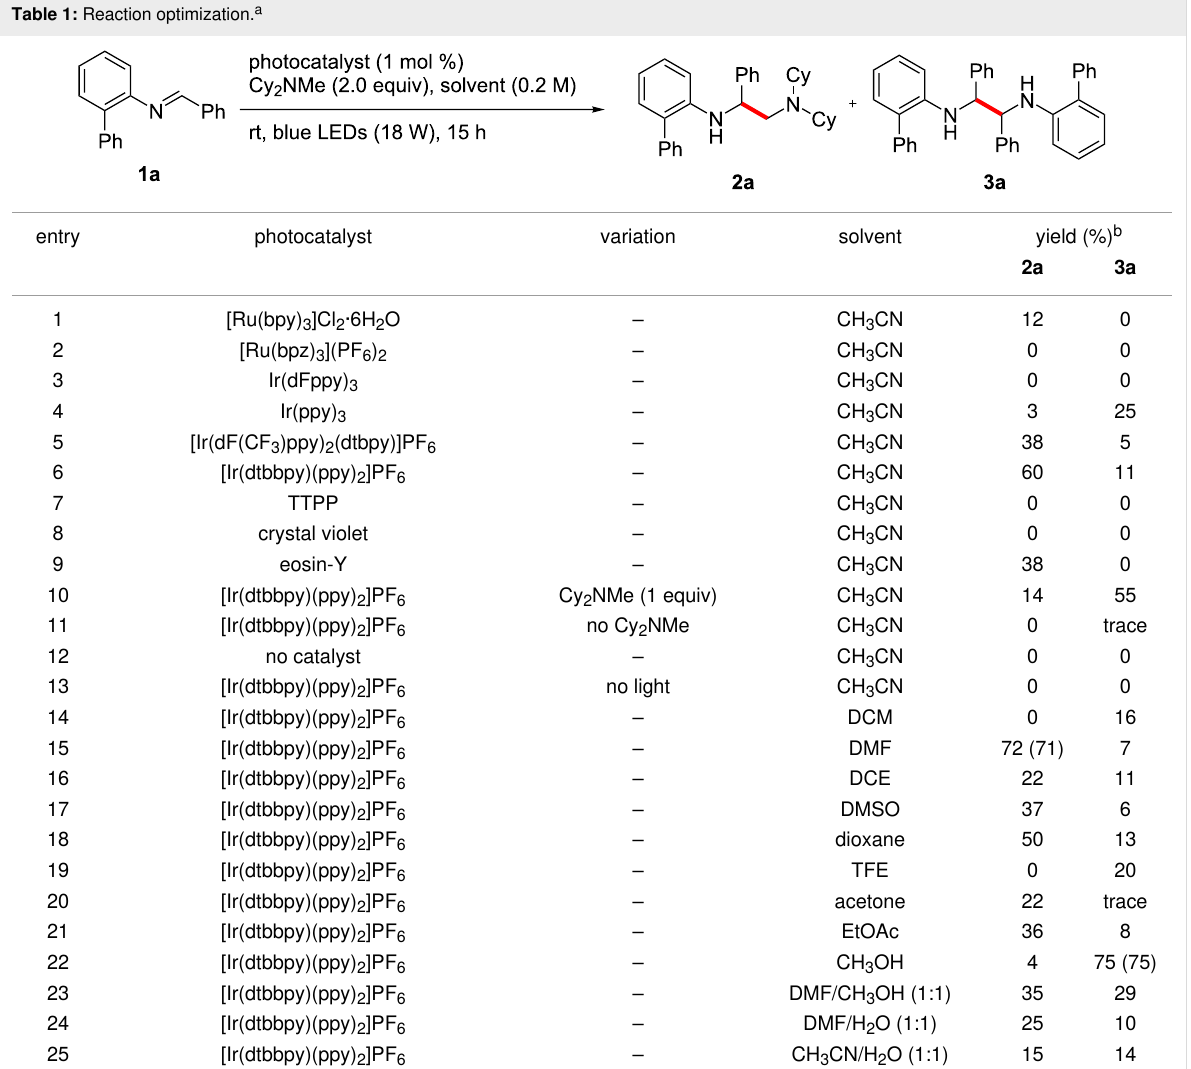
Table 1: Reaction optimization.